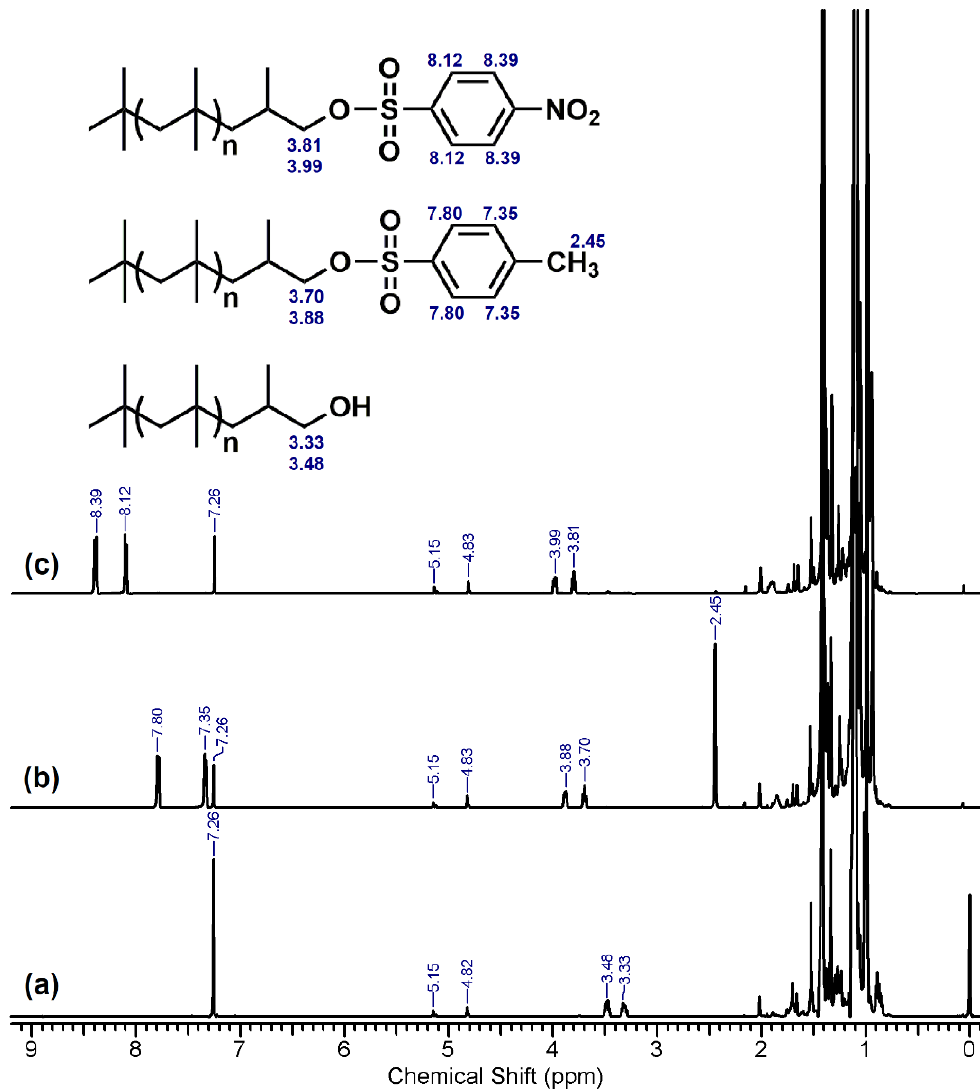
Figure 2. Figure 2. 1 H NMR spectra of PIB exo -OH ( a ), PIB exo -OTs ( b ) and PIB exo -ONs ( c ).